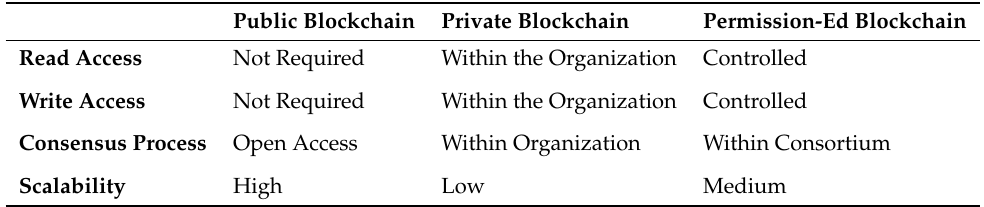
Table 1. Classification of Blockchains.